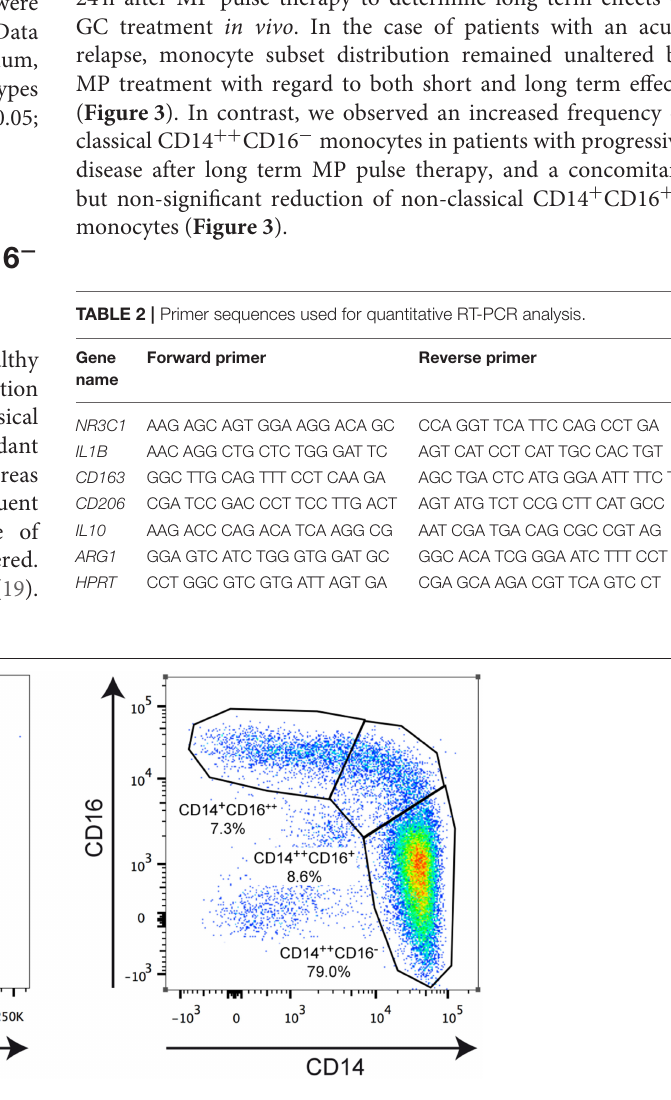
FIGURE 1 | Representative FACS analysis illustrating the applied gating strategy. Monocytes were isolated from an MS patient and stained for CD14 and CD16 surface expression using fluorochrome-conjugated monoclonal antibodies. The left plot depicts the gating for living cells based on forward scatter (FSC) and side scatter (SSC). The right plot shows gating for classical CD14 ++ CD16 − monocytes, intermediate state CD14 ++ CD16 + monocytes, and non-classical CD14 + CD16 ++ monocytes. The borders of the gates and the percentages of cells therein are indicated in each plot.